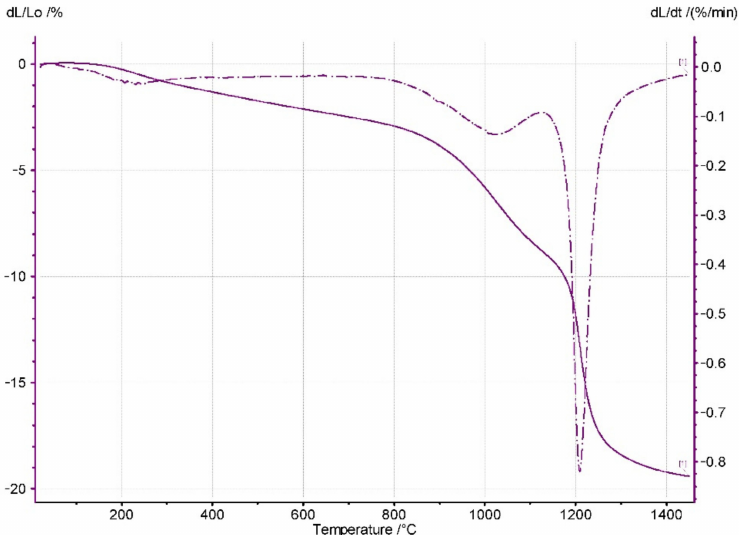
Figure 5. Shrinkage vs. temperature of the powder compact. Rate of the temperature increase: 5 ◦ C/min.